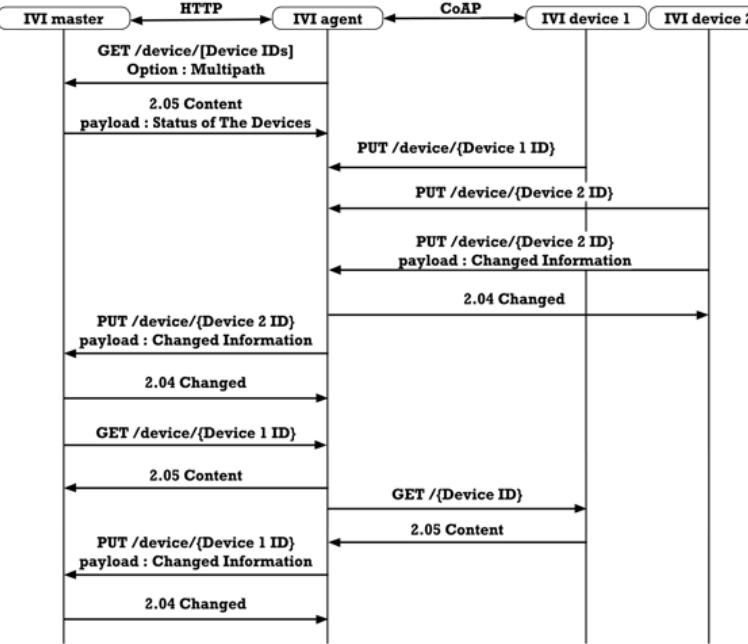
Figure 12. Operation flow for IVI device monitoring .